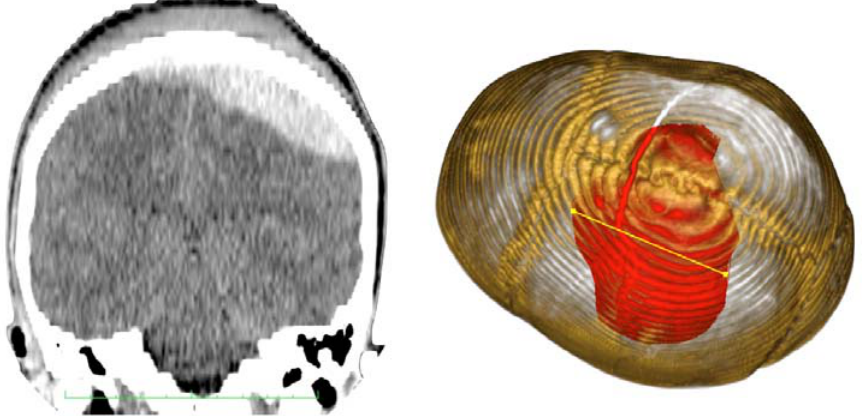
Figure 1. CASE 1. Preoperative CT scans. The visualization of the hematoma by transparency facilitates the spatial perception of the surgeon. In this particular case, the patient had an epidural hematoma beneath the superior sagittal sinus with a bilateral extension. The measured diameter is 7 cm (see also VIDEO 1).